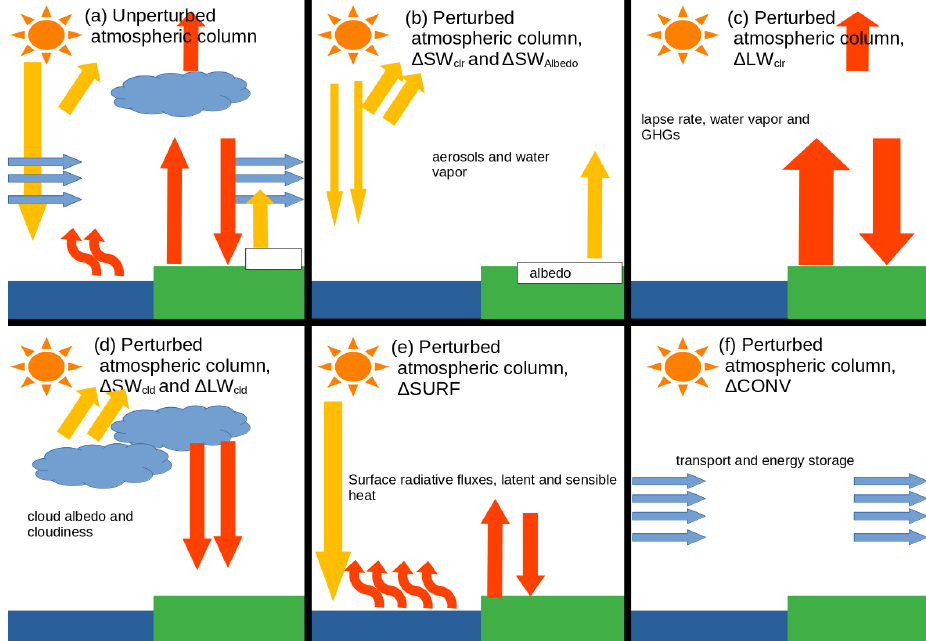
Figure 1. Illustration of the local atmospheric energy budget in a single atmospheric column from the surface to the top of model atmo- sphere (TOA). We attribute the change in local surface temperature to changes in different terms of the local energy budget. (a) Unperturbed conditions, where red arrows indicate longwave (thermal) radiation, yellow arrows indicate shortwave (solar) radiation, blue arrows indicate horizontal incoming and outgoing energy, and curvy red arrows indicate latent and sensible heat. Under perturbed conditions, we decompose the change in the energy budget to (b) the change in TOA solar radiation due to changes in surface albedo and to the change in shortwave clear-sky flux (separately). The change in shortwave clear-sky flux is mainly caused by changes in aerosol concentrations or changes in at- mospheric water vapor; (c) the change in longwave TOA flux, which is mainly caused by changes in atmospheric water vapor concentrations, atmospheric thermal structure (lapse rate) or greenhouse gas concentrations; (d) changes in longwave and shortwave TOA fluxes, separately, due to changes in cloudiness and cloud microphysics; (e) the combined change in surface energy balance, including the change in the net shortwave and longwave energy flux into the surface and changes in latent and sensible heat fluxes; (f) the combined change in horizontal energy transport and internal energy of the atmospheric column, calculated from the convergence of